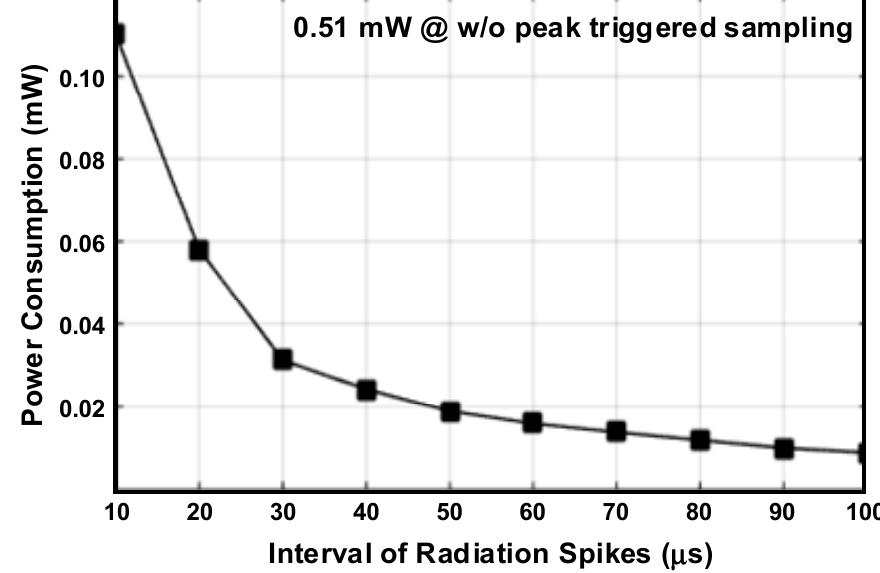
Figure 4. Simulated power consumption of the analog-to-digital converter (ADC) with the peak-triggered sampling scheme according to the interval of radiation spikes.